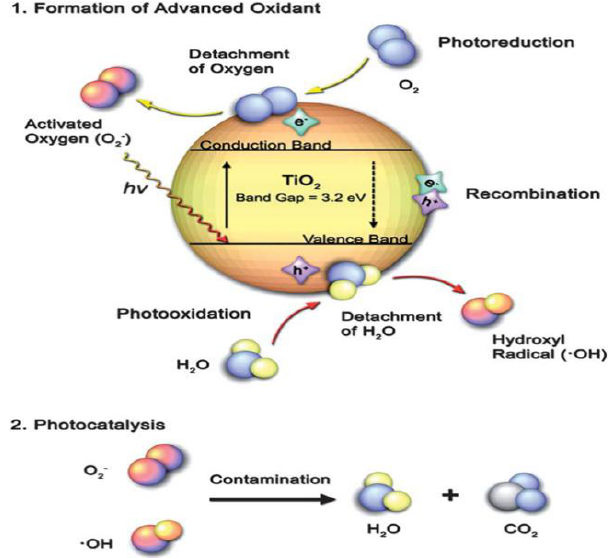
Figure 1. Schematic diagram showing the TiO 2 photocatalysis. Adapted with permission from [7]; Copyright 2011 The Royal Society of Chemistry.